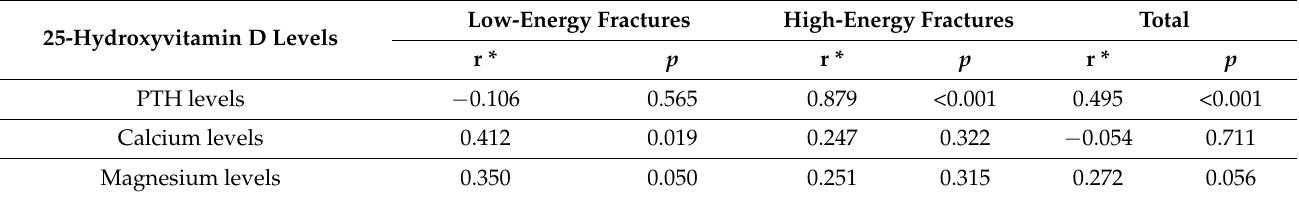
Table 3. Correlation between the 25-hydroxyvitamin D levels and tested